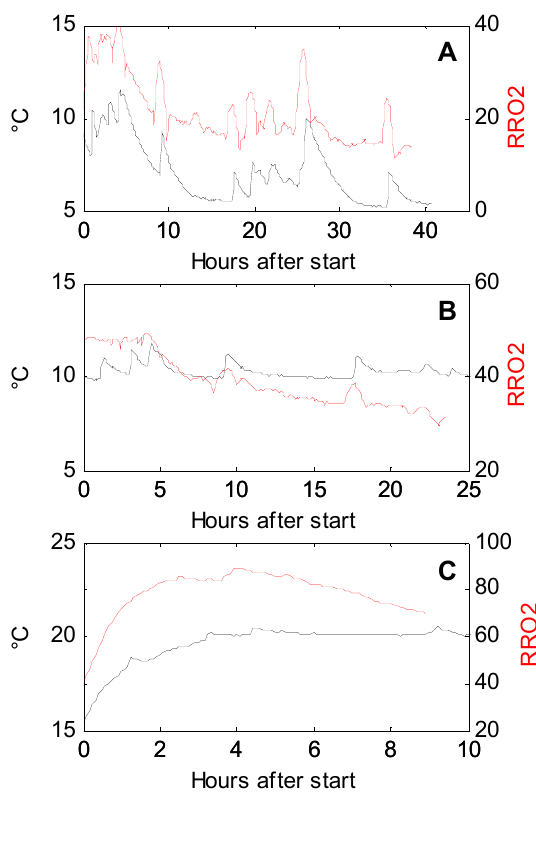
Figure 5. The temperature and respiration rate relationship for each of the three temperatures 5 °C ( A ), 10 °C ( B ) and 20 °C ( C ). In each subfigure the red line refers to the respiration data, whereas the black line represents the temperature data from the same sensor. The respiration rates are only shown until the sensors reached the minimum oxygen